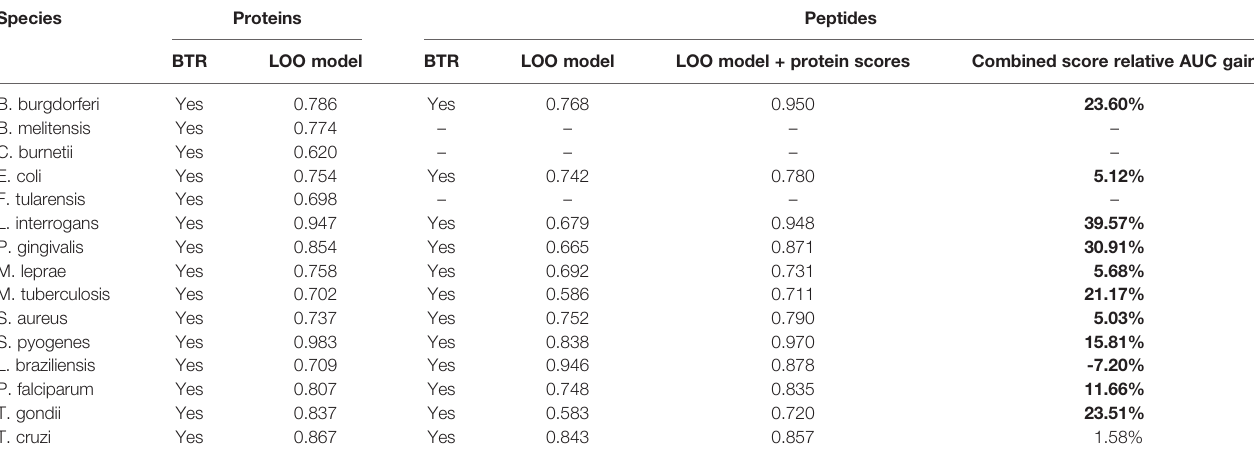
TABLE 5 | Prediction results for the leave-one-out generic models.